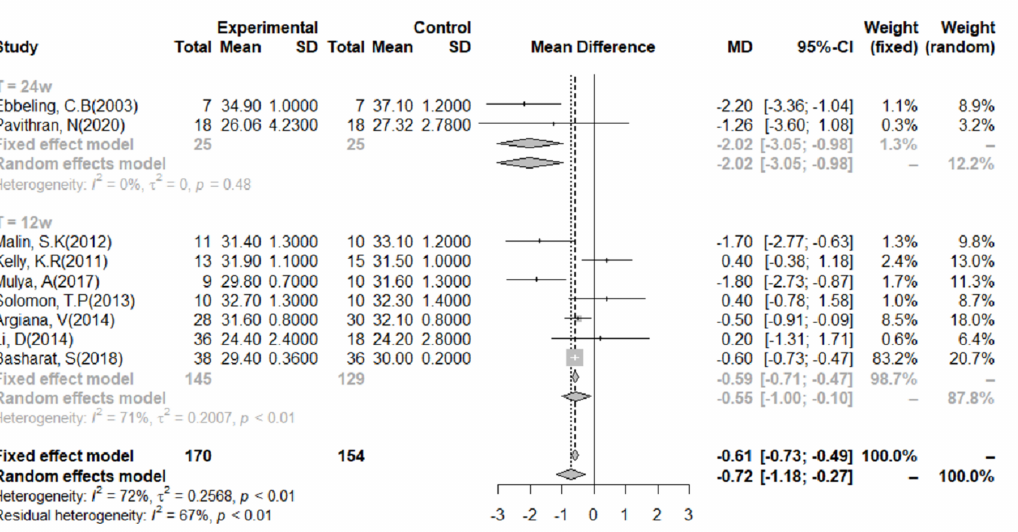
Figure 3. Meta-analysis of the effect of a low-glycemic index diet on body mass, according to the duration of the intervention. A random-effects model and mean difference analysis were used.